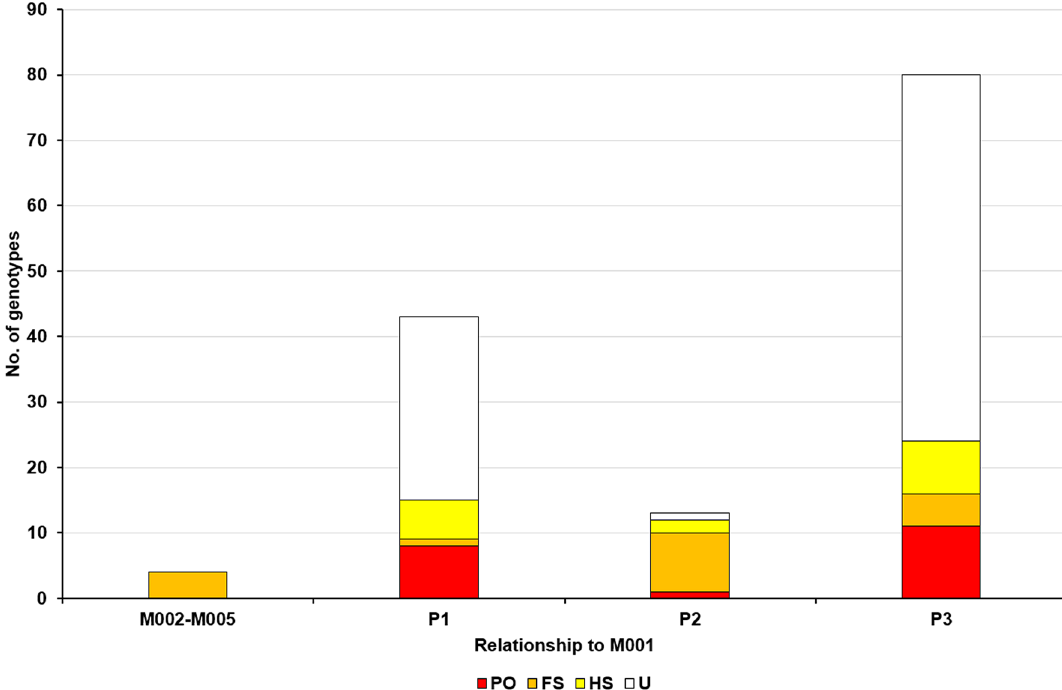
Figure 6. Histogram of kinship categories between the analyzed genets of sweet chestnut and the most common genotype M001. Four pedigree relationships are represented by colors in the columns: unrelated (U) in white, half-siblings (HS) in yellow, full-siblings (FS) in orange and parent-offspring (PO) in